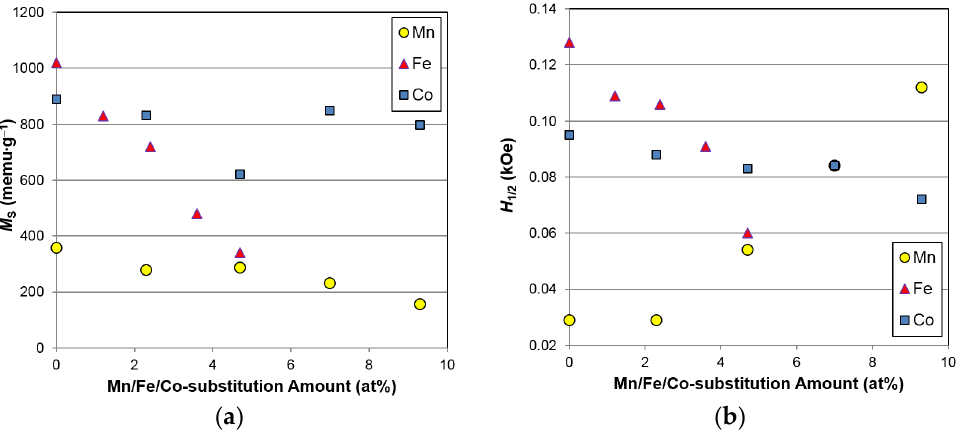
Figure 12. Changes in ( a ) saturated magnetic susceptibility ( M S ); and ( b ) strength of the applied magnetic field corresponding to half of M S ( H 1/2 ) with increasing substitution amounts.